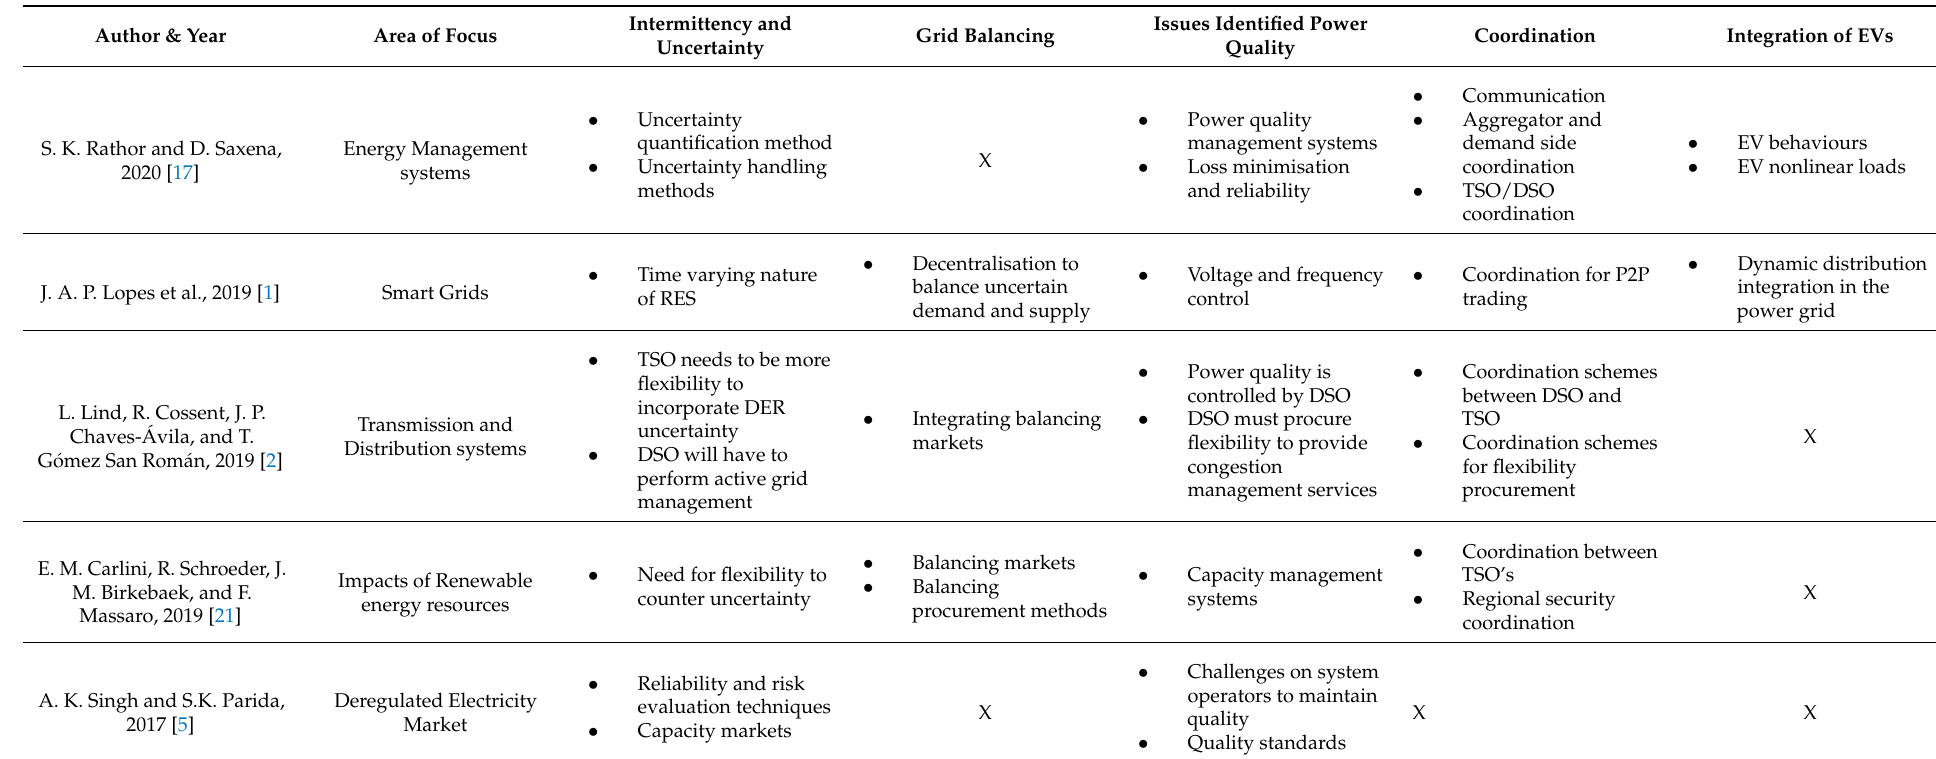
Table 2. Analysis of review articles summarizing the challenges of integrating distributed energy resources in the electric